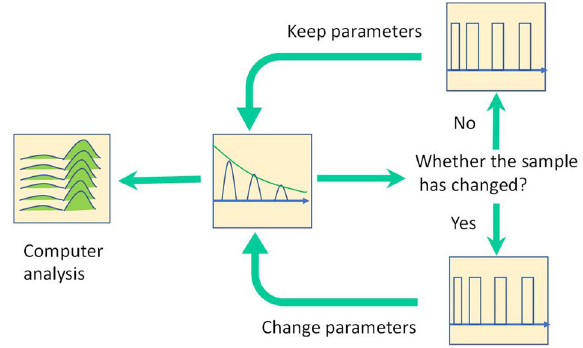
Figure 3. A closed-loop control scheme for samples in motion.